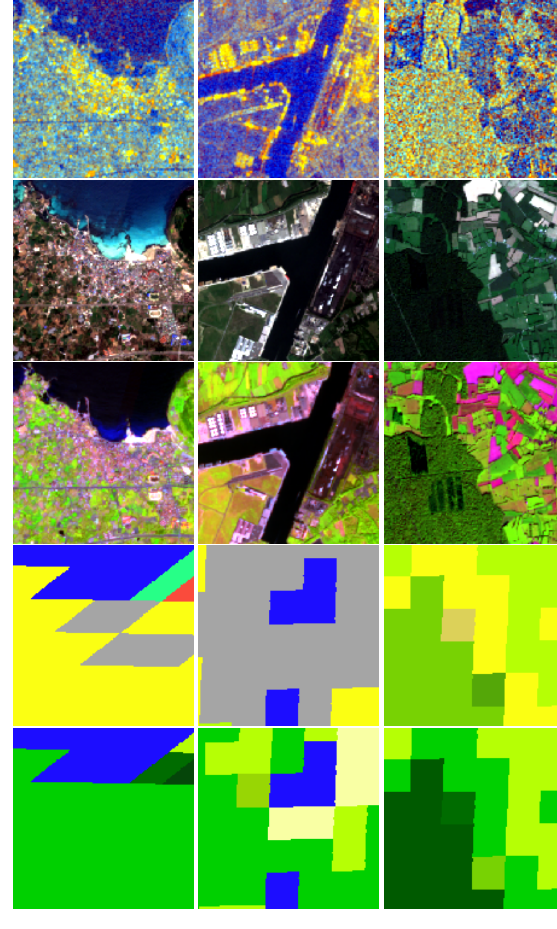
Figure 4. Images extracted from 3 example patch triplets. Each column shows (from top to bottom): False color Sentinel-1 SAR (R: VV, G: VH, B: VV/VH), Sentinel-2 RGB, Sentinel-2 SWIR, IGBP Land cover, LCCS Land cover. Note that while the GSD of all patches is